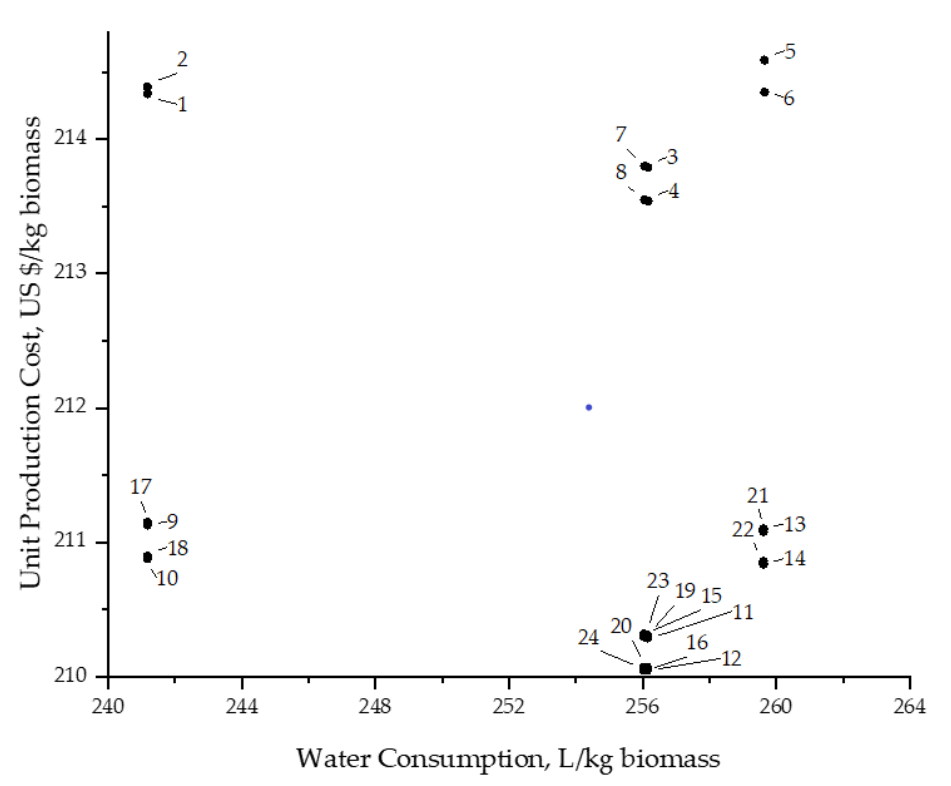
Figure 9. Total water consumption vs. total production cost per kg biomass produced.